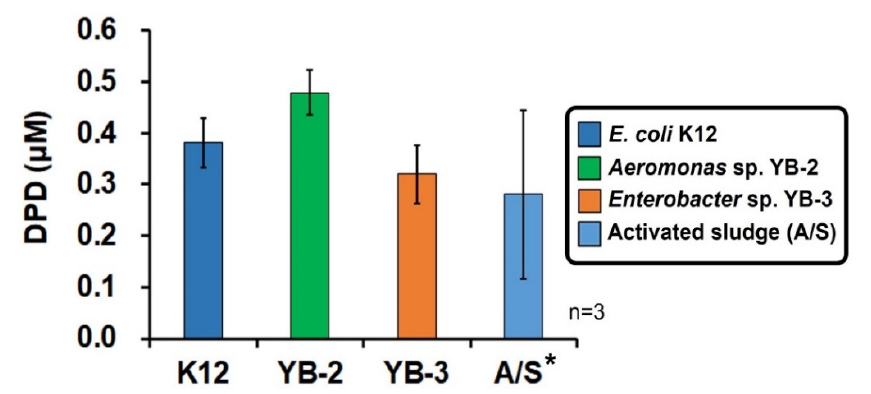
Figure 4. Determination of the ( S )-4,5-dihydroxy-2,3-pentandione (DPD) concentration secreted from various microorganisms. The error bars represent one standard deviation ( n = 3, * n = 2).